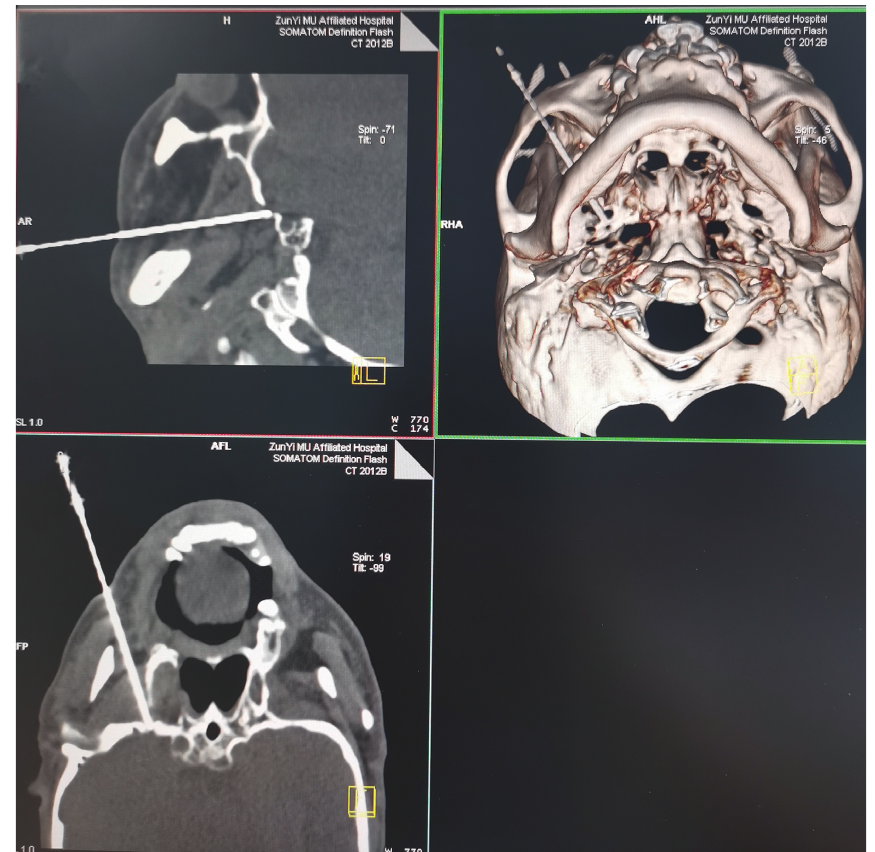
Figure 2: The images of pulsed radiofrequency